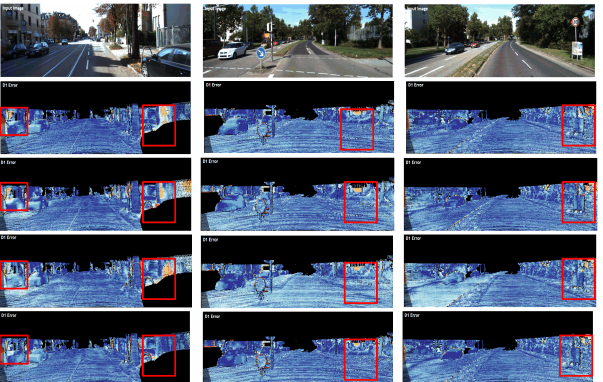
Figure 10. The visualization results on the KITTI2015 dataset, in which the first line is the original map, the second line is the visualization results of AANet+, the third line is the error map of GCNet, the fourth line is the error map of AANet and the fifth line is the error map of our proposed model network.The red box represents a comparison between MCAFNet and other network